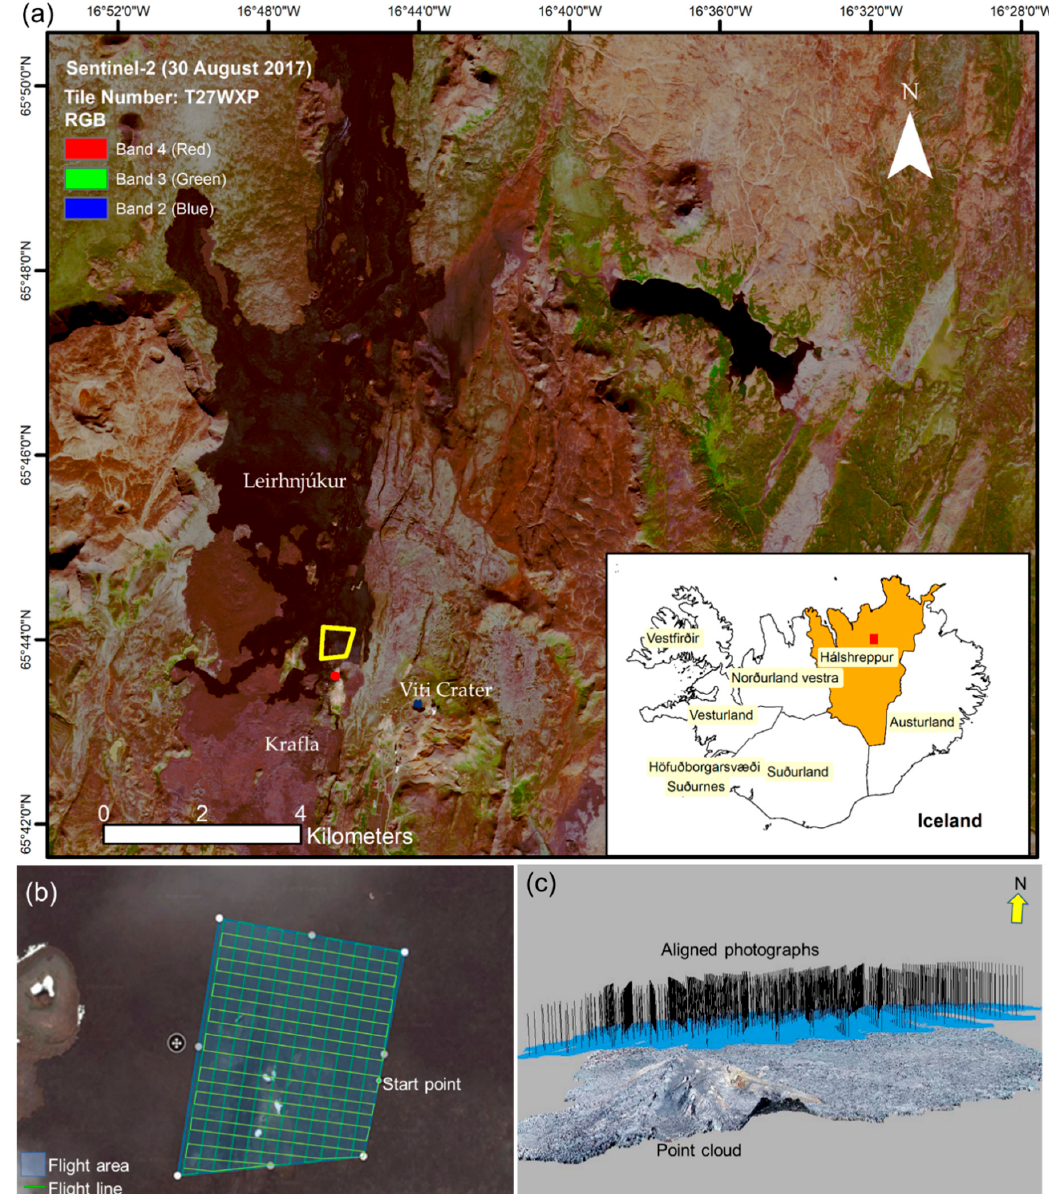
Figure 1. Location map and flight details: ( a ) contextual map of the study site in true color composite (RGB:432). The red rectangle in the inset political map in ( a ) shows the geographical location of the study site in Iceland. The yellow quadrilateral shows the relative position of the flight site. The red dot shows the unmanned aerial vehicle (UAV) launch site; ( b ) area of interest and the flight lines in a double grid format; ( c ) aligned photographs and dense point cloud for the study area for the survey on 11 July 2018. Image credit for ( a ): map generated using European Space Agency’s (ESA’s) Sentinel-2 multi-spectral instrument (MSI) remote sensing data acquired under the European Commission’s Copernicus Programme and downloaded from United States Geological Survey (USGS) EarthExplorer. Image credit for ( b ): the flight lines are produced using Pix4Dcapture flight planning freeware with the Google Earth (GE) image in the background and the data provider for the GE image is CNES /